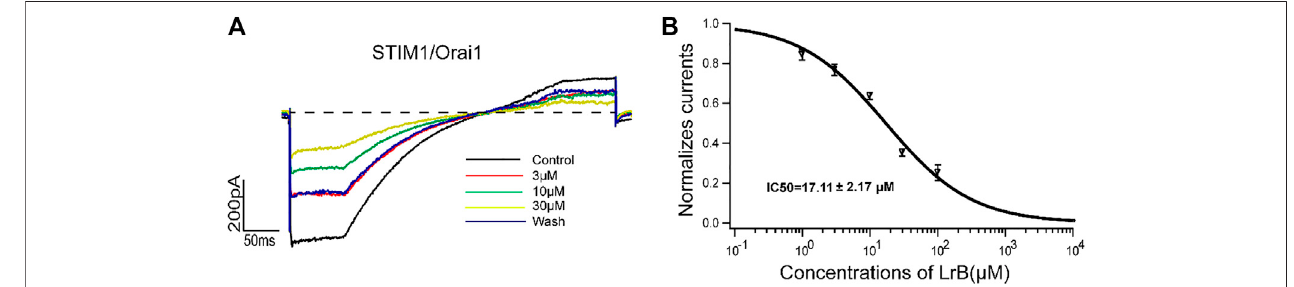
FIGURE 5 | Effects of LrB on STIM1/Orai1 currents. (A) Representative whole-cell currents recorded in STIM1/Orai1 expressing HEK293 T cells after treatment with 3, 10, or 30 μ M LrB, black trace represents the baseline control current. Red, green, and yellow traces represent the currents recorded after the treatment of3, 10, and30 μ MLrB,respectively,andthebluetraceisthecurrentunderexternalsolutionwashingoffLrB. (B) Concentration-responsecurveofLrBinhibitiononSTIM1/Orai1 currents (IC50 (cid:2) 17.11 ± 2.17 μ M, n (cid:2) 5, Mean ± SEM).